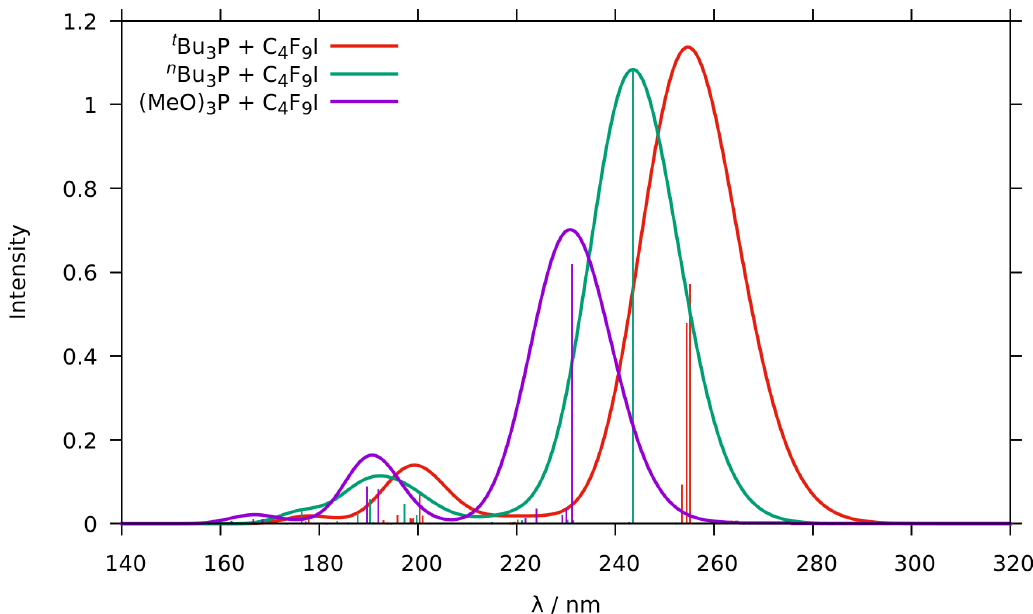
Figure 5. Calculated absorption spectra of the phosphine and phosphite adducts in DCM including spin–orbit coupling